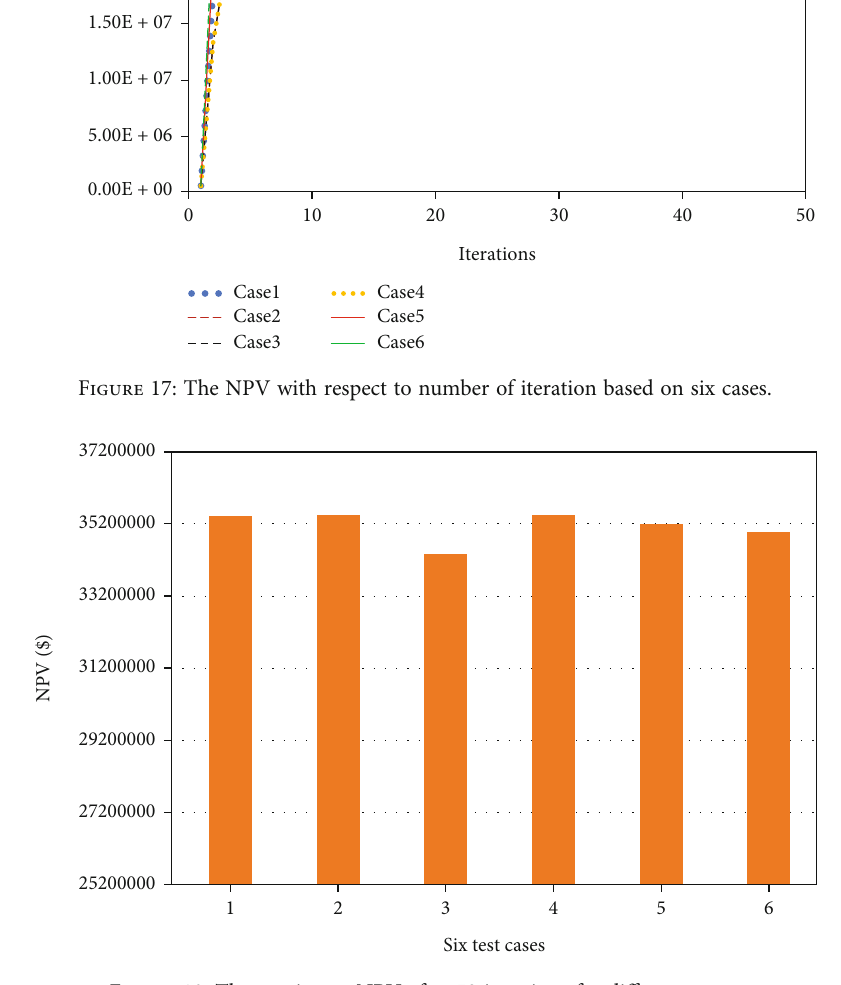
Figure 18: The maximum NPV after 50 iterations for di ff erent